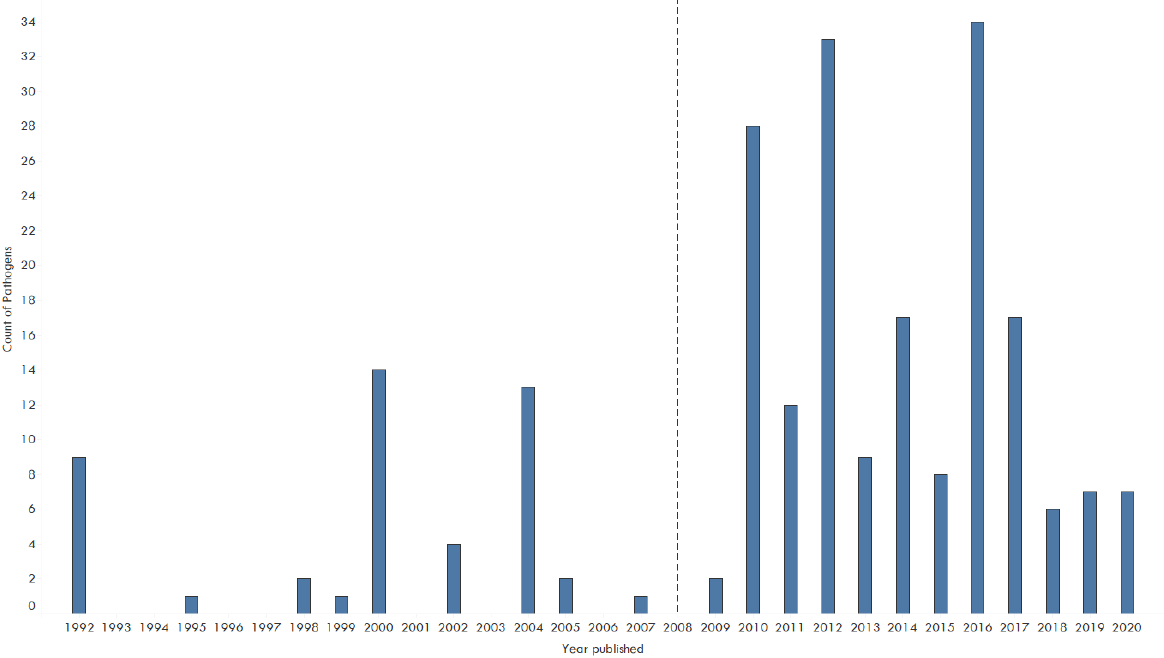
Figure 3. Number of pathogens including viruses, bacteria, endoparasites, ectoparasites and fungi linked to the illegal wildlife trade documented in literature between 1990 and 2020. The reference line indicating the publication of the last review in 2008 [9], in which no amphibian illegal trade was documented.